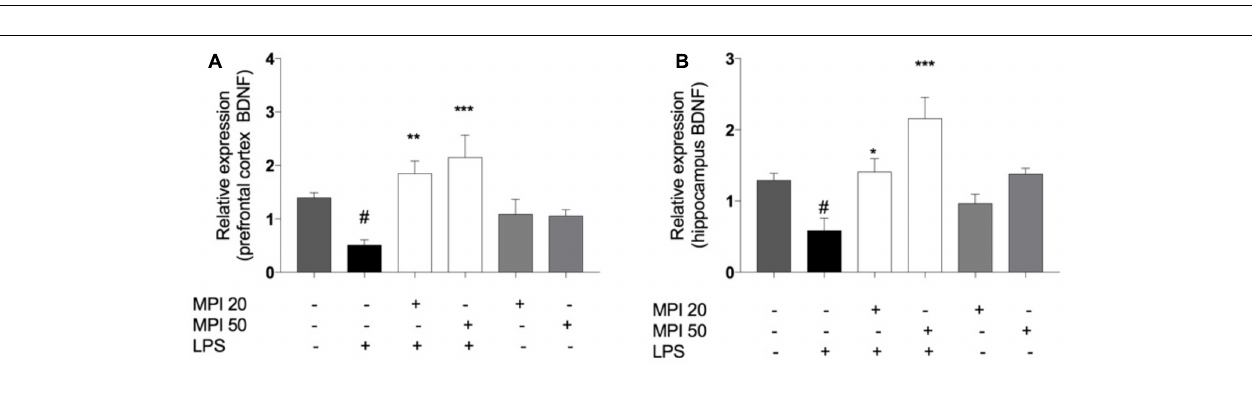
FIGURE 8 | BDNF expression in (A) PFC and (B) HC of LPS-induced group mice decreased significantly when compared to the control group ### P < 0.001. MPI (20–50 mg/kg) followed by LPS administration prevented the decrease of BDNF expression in (A) PFC ( F 5 , 30 = 8.751, P < 0.001; post hoc ∗∗ P < 0.01, ∗∗∗ P < 0.001, n = 6) and in (B) HC ( F ∗ P < 0.05, ∗∗∗ P < 0.001, n = 6) ( ∗∗∗ )( ∗∗ ) when compared to the LPS-induced group. 5 , 30 = 6.775, P < 0.001, post hoc # P < 0.05 when compared to the control group. No significant differences observed among the control and MPI followed by saline admnistration. Data were analyzed using a one-way ANOVA followed by the Student–Newman–Keuls multiple comparisons post hoc test. Error bars represent